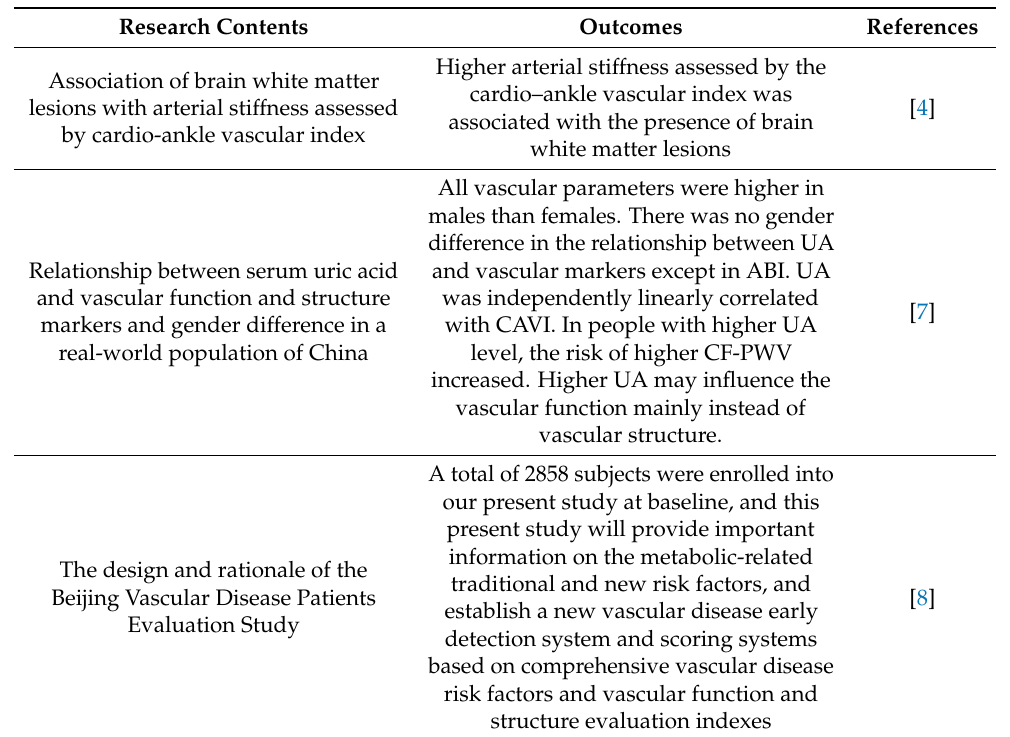
Table 2. Beijing Vascular Disease Evaluation